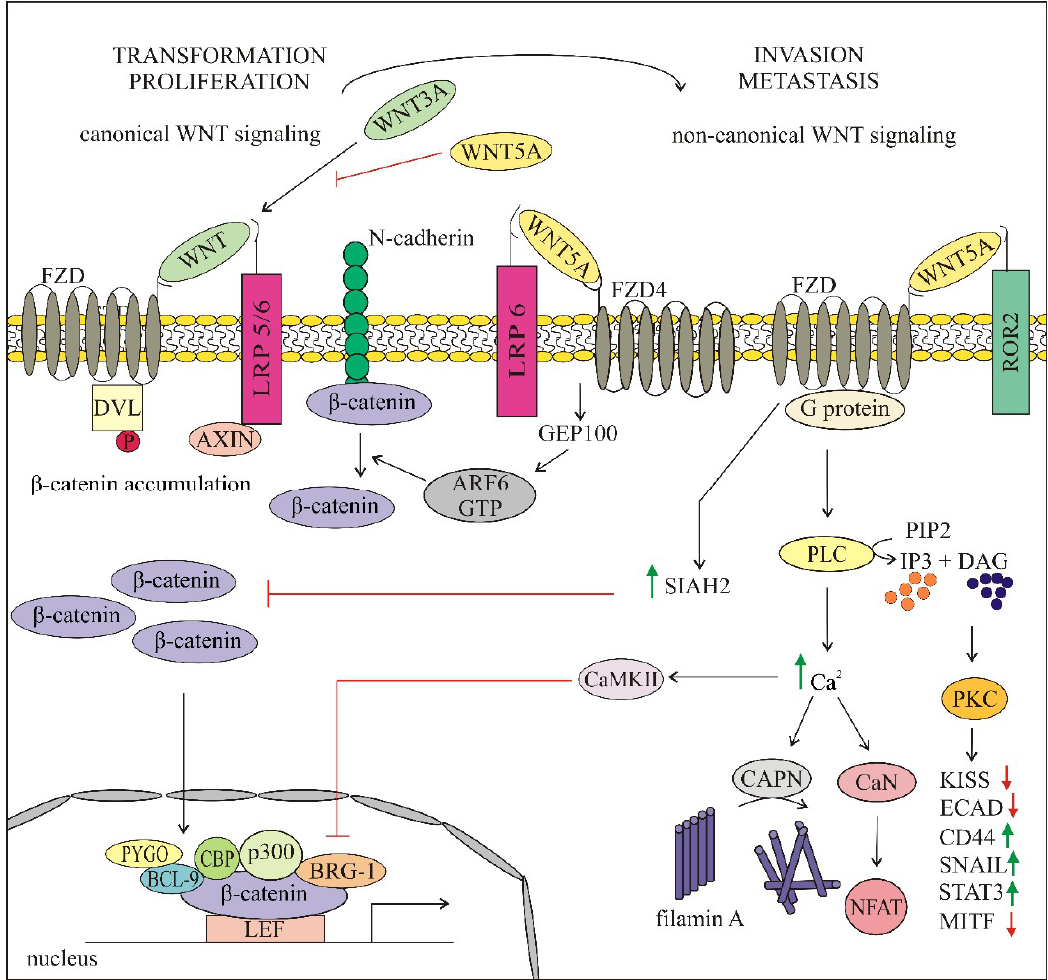
Figure 3. Proposed model of the crosstalk between canonical and non-canonical WNT-signaling in melanoma. In the canonical WNT pathway, WNT–FZD/LRP5/6 interaction initiates β-catenin dependent signaling. β-catenin translocates to the nucleus to drive the transcription of target genes. This is critical for early steps of transformation when melanocytes bypass senescence and start to proliferate, thus promoting first the radial then vertical growth of melanoma. An increase of WNT5A that activates non-canonical WNT-signaling inhibits β-catenin-signaling and enhances the invasiveness of melanoma cells crucial for metastatic spreading of melanoma. Green and red arrows indicate increase and decrease, respectively.